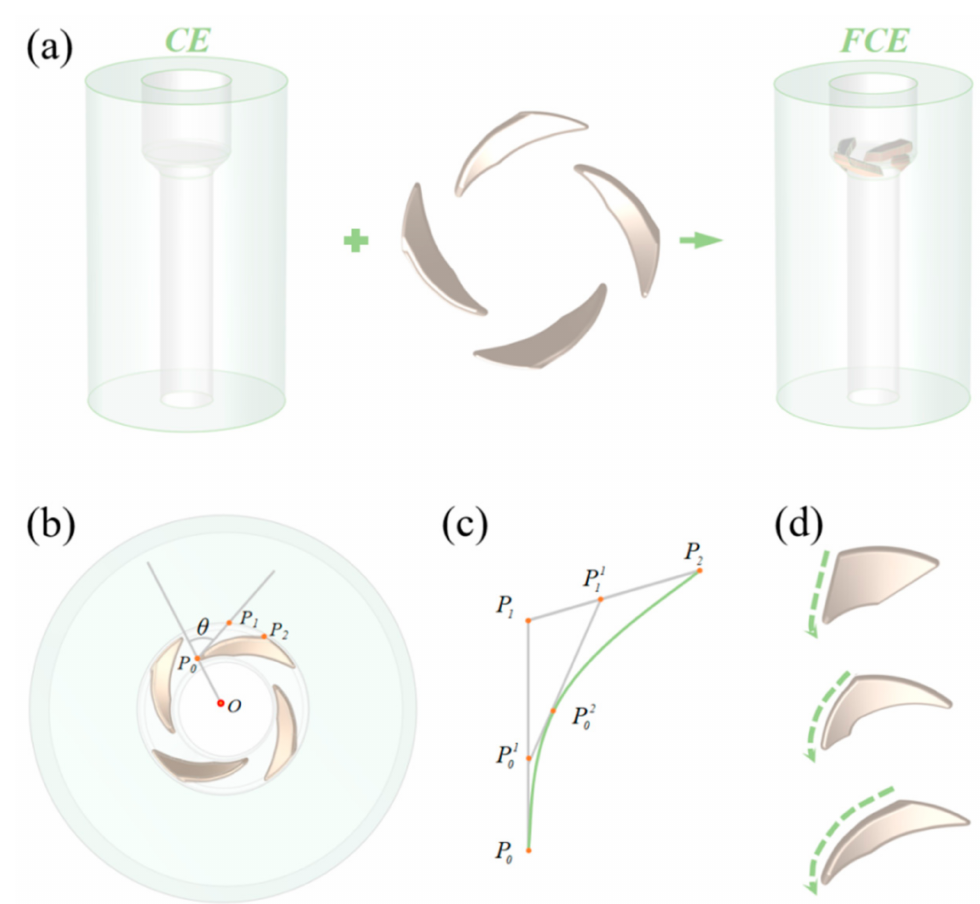
Figure 1. Schematic illustration of flow control extrusion (FCE): ( a ) the principle of FCE, ( b ) the control of bulges, P 0 , P 1 , and P 2 are points located at the edge of deformation zone; ( c ) the structure design of bulges, P 01 and P 11 mean the moving point on P 0 P 1 and P 1 P 2 respectively, and the trajectory of P 02 constructs the curve P 0 P 2 ; ( d ) severe structure of bulges with increase radian.